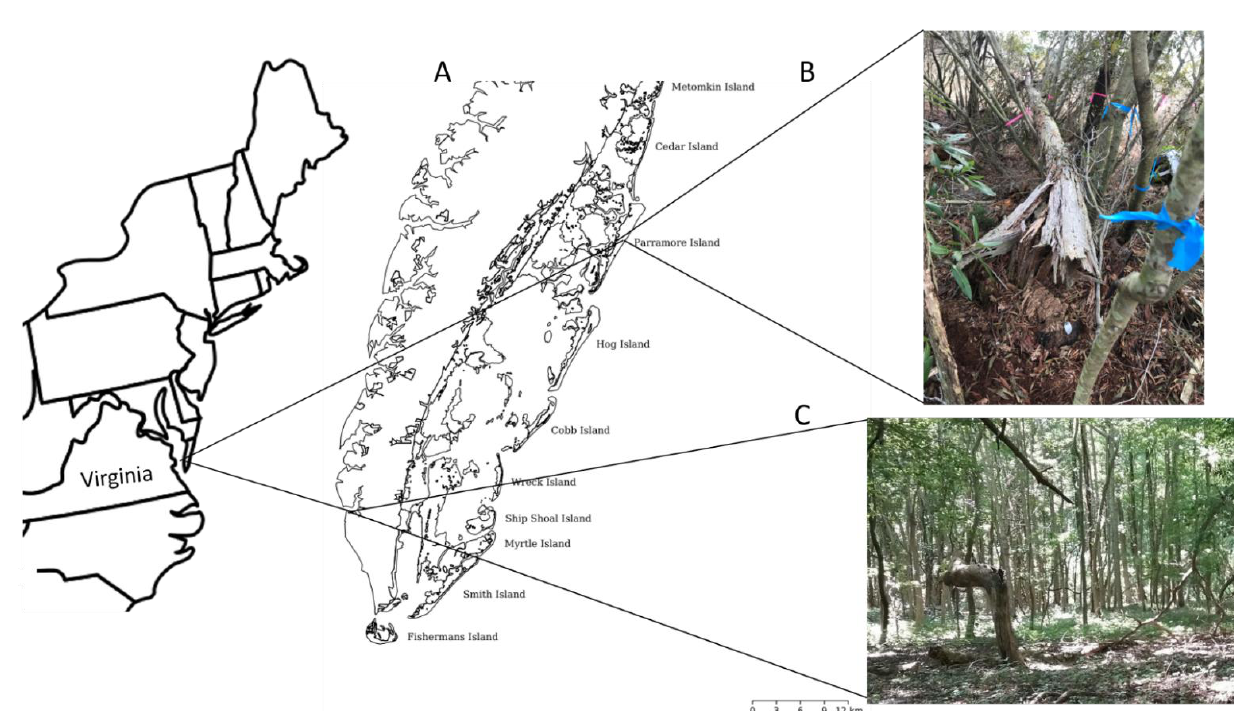
Figure 1. ( A ) Delmarva Peninsula of Virginia showing locations of Savage Neck Dunes and Parramore Island; ( B ) Maritime forest on Parramore Island; ( C ) Maritime forest on Savage Neck Dunes.